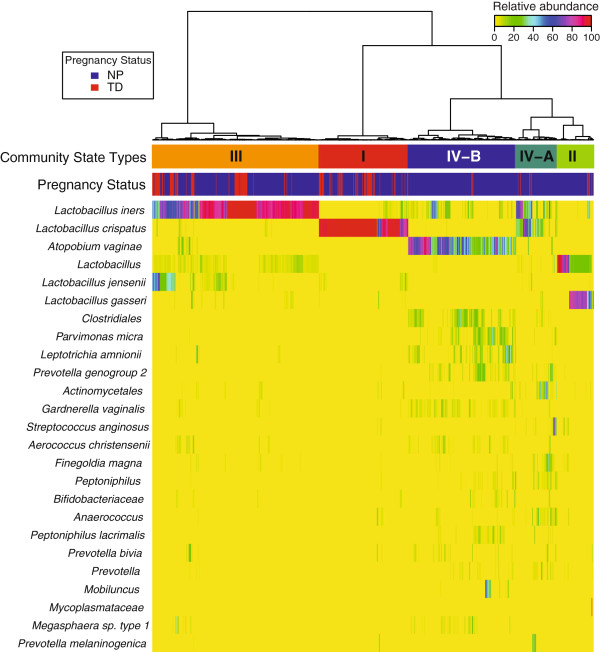
Heatmap of percentage abundance of microbial taxa found in the vaginal microbial communities of 22 normal pregnant women who delivered at term and 32 non-pregnant women sampled longitudinally. Ward linkage hierarchical clustering of Jensen-Shannon metric identified five community state types (CST I, II, III, IV-A and IV-B). The upper color bar shows the five community state types while the lower color bar shows the pregnancy status of each sample (NP: Non Pregnant; TD: Term Delivery).